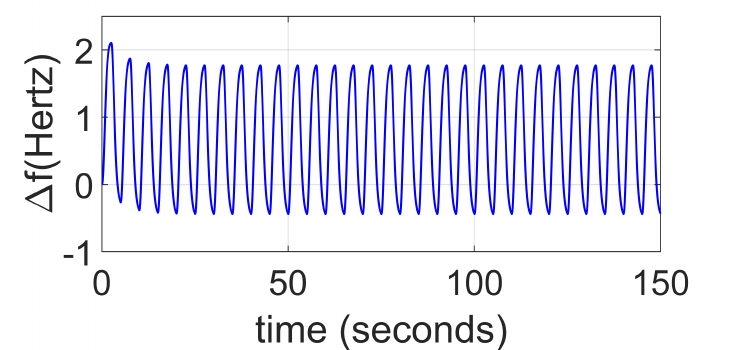
Figure 8. Frequency measurement under pulse attack.